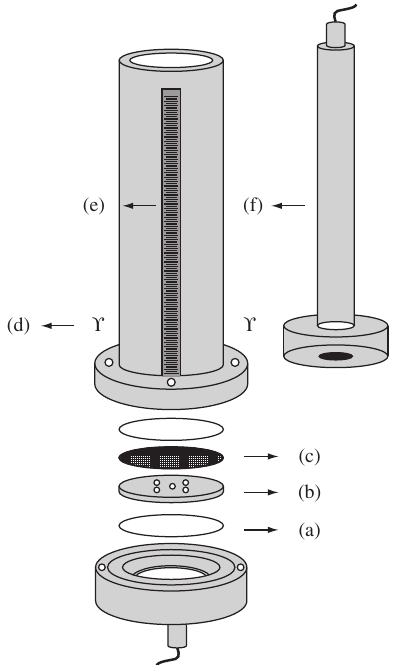
Figure 1. Drawing of the column used in this work: a) rubber gasket, b) distributor (perforated plate), c) screen (60 μ m), d) screw, e) ruler, and f) piston 20